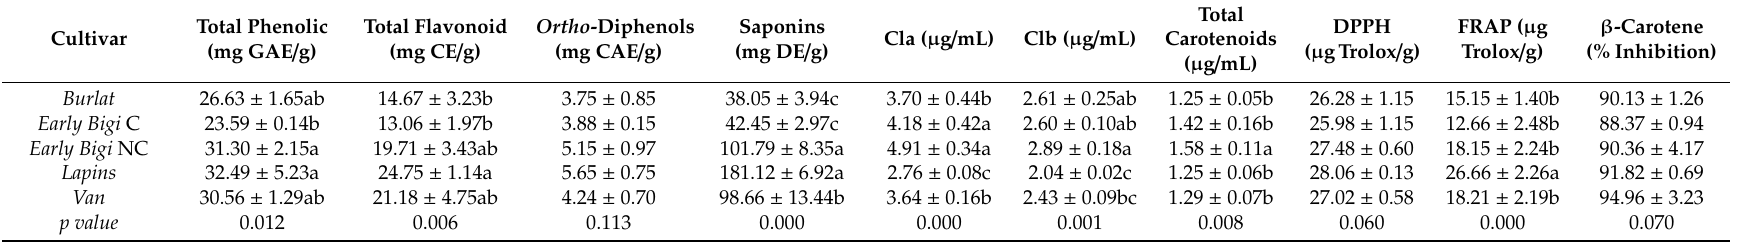
Table 1. Bioactive content and antioxidant activity of sweet cherry stems from four di ff erent